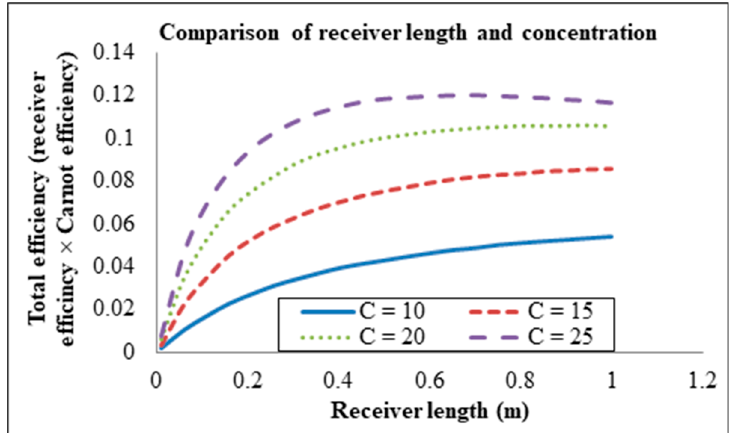
Figure 17. Comparison of receiver length and solar concentration with adjusted Carnot efficiency.